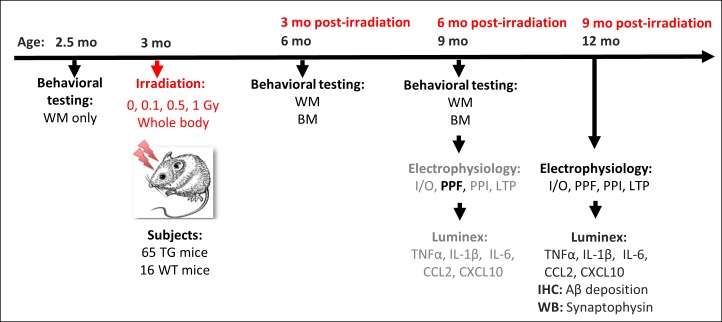
Timeline and design of the experiment.Sixty-five transgenic (TG) and 16 wild type (WT) male mice entered the study at the age of 2.5 months. Animals were behaviorally tested in the water maze (WM) before irradiation to determine the “baseline” performance. At the age of ~3 months they were irradiated with 0.1, 0.5, or 1.0 Gy of ~150 MeV protons. Post-irradiation, the behavioral testing consisted of the WM followed by the Barnes maze (BM). In half of the TG mice, the last behavioral testing was followed by in vitro electrophysiological recordings at 6 months post-irradiation. The second half of TG mice and all WT mice were electrophysiologically tested at 9 months post-irradiation. Electrophysiological protocols: (I-O) Input-Output tests; (PPF) Paired-Pulse Facilitation; (PPI) Paired-Pulse Inhibition; (LTP) Long-Term Potentiation. The grayed out methods at 6 months post-irradiation indicate the experiments that did not detect statistically significant radiation-induced changes and were not included in the manuscript. The exception was PPF (black), which showed significant age-related increase between 6 and 9 months post-irradiation. Cortices were used for Luminex cytokine assays. Immunohistochemistry (IHC) of Aβ deposition and Western blotting (WB) analyses of the presynaptic protein synaptophysin were performed at 9 months post-irradiation only.